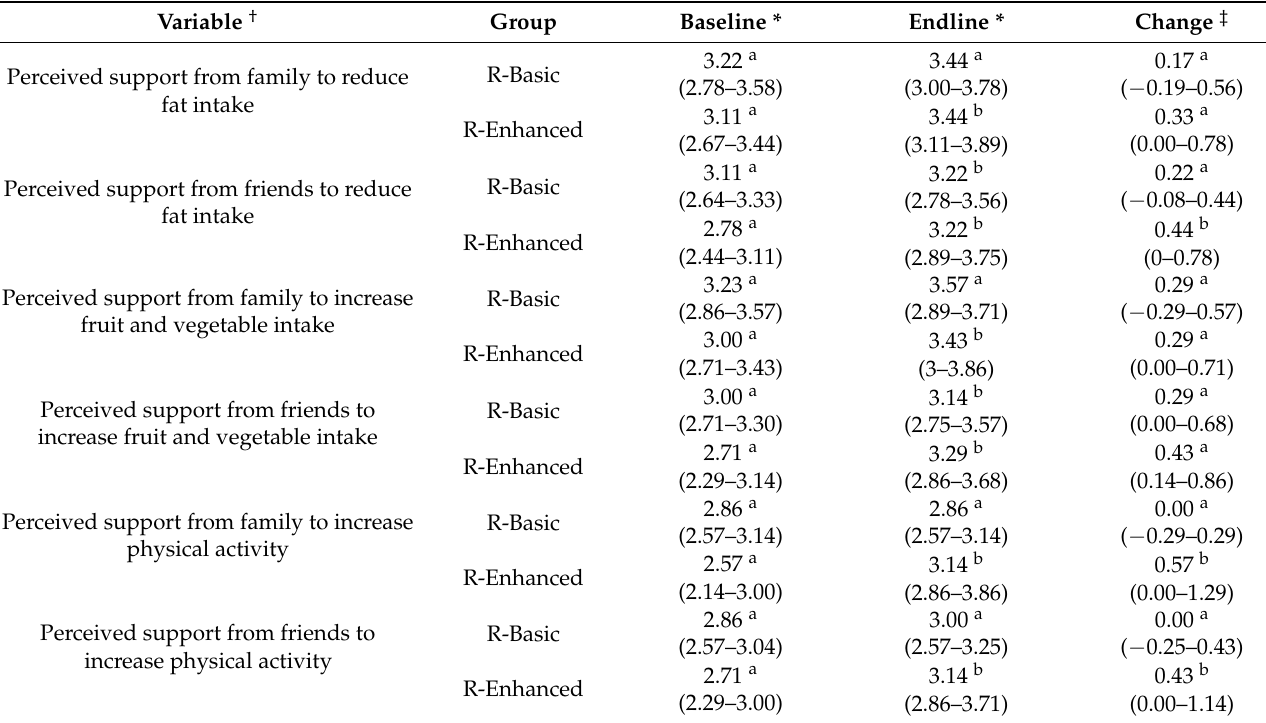
Table 4. Baseline and endline perceived social support from family and friends for healthier foods and physical activity in Rashakaty Basic ( n = 54) and Rashakaty Enhanced ( n = 111) groups.